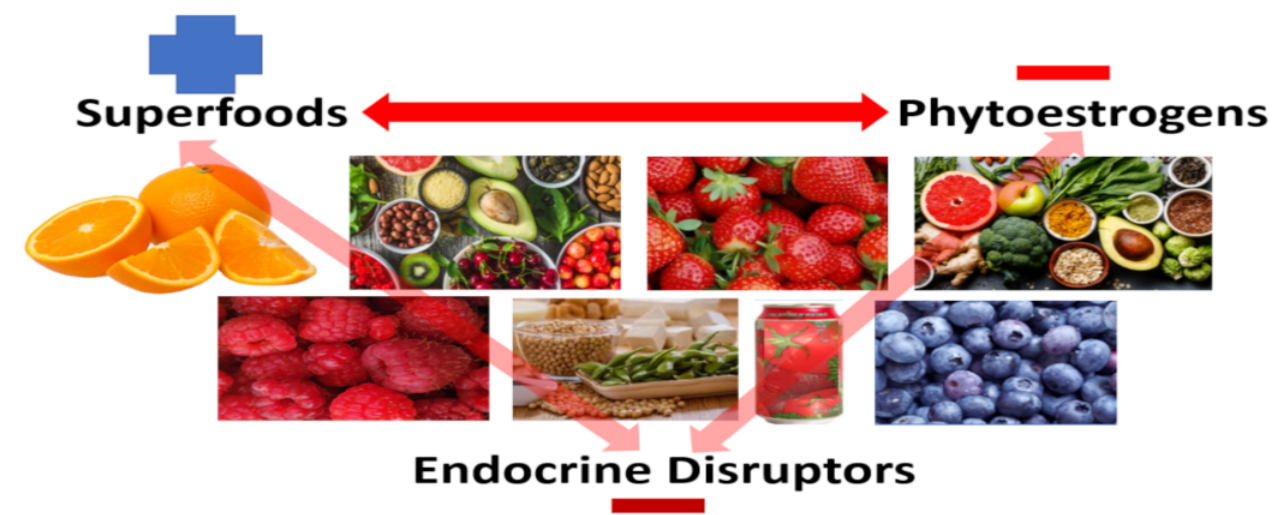
Figure 2. Superfoods have a positive connotation shown by the blue plus symbol because they contain antioxidants and other compounds that support good health, while superfoods also contain phytoestrogens, which have a negative connotation (red minus symbol) because they bind to estrogen receptors and hence are classified as endocrine-disruptors (deep-red minus symbol) that is alarming to the public. Thus, it is a matter of perspective of how each is